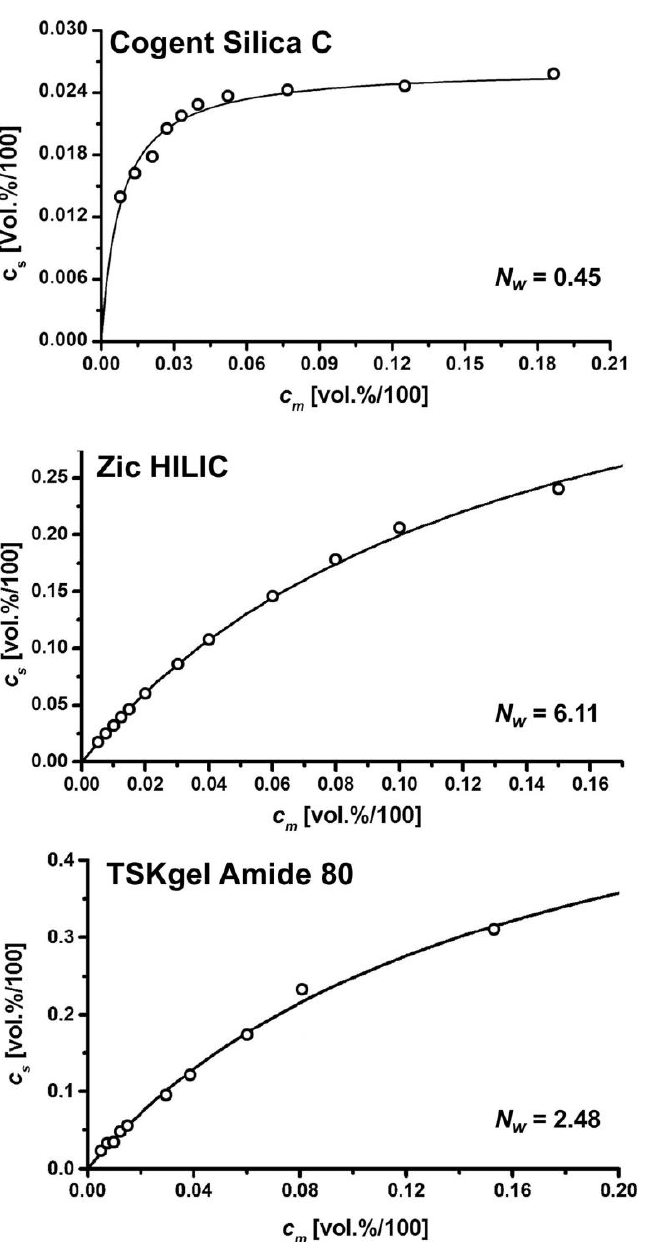
Figure 2. Sorption isotherms of water from acetonitrile on Cogent Silica C, ZIC HILIC and TSKgel Amide